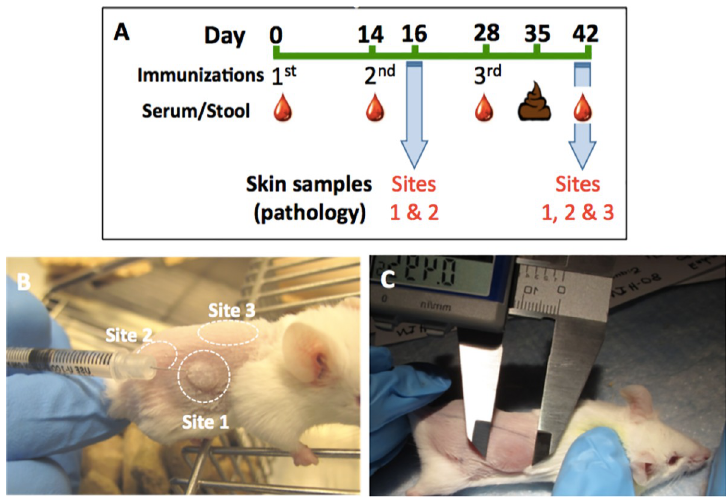
Fig 1. Study design and measurement of skin induration. (A) BALB/c mice (n = 5-7/group) were immunized intradermally on days 0, 14, and 28. Blood was obtained on days 0, 14, 28 and 42, and fecal samples were obtained on day 35. In a subset of mice, pathology biopsies were taken from immunization site 1 (S1) and immunization site 2 (S2) on d16, and from S1, S2 and immunization site 3 (S3) on d42. (B) Mice were shaved on the dorsum and immunized on days 0, 14, and 28 at S1, S2 and S3, respectively. (C) Induration was measured (in mm) using a digital caliper by length (caudal to cranial) and width (medial to lateral) and then the two measurements were averaged.